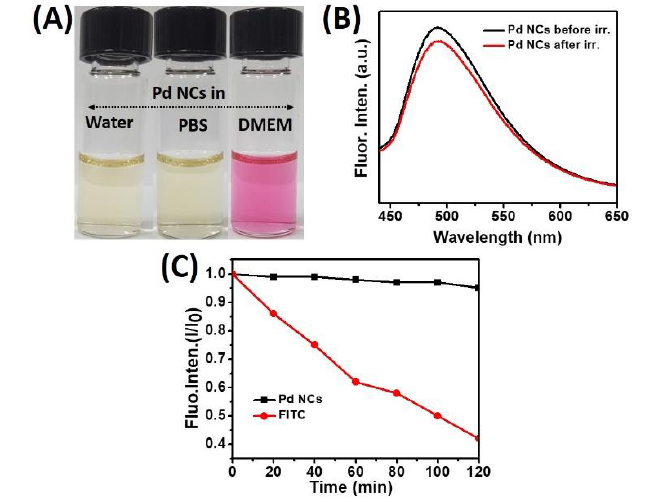
Figure 3. Colloidal and photostability properties of Pd NCs. ( A ) colloidal stability of Pd NCs in various media: water, PBS and DMEM. ( B ) Fluorescence emission spectra of Pd NCs before and after photoillumination at a photoexcitation wavelength of 420 nm. ( C ) Photostabilities of Pd NCs upon comparison with fluorescein isothiocyanate (FITC) dye under exposure of 100 W Hg lamp (output power intensity: 200 mW/cm 2 at 365 nm wavelength) for 2 h.